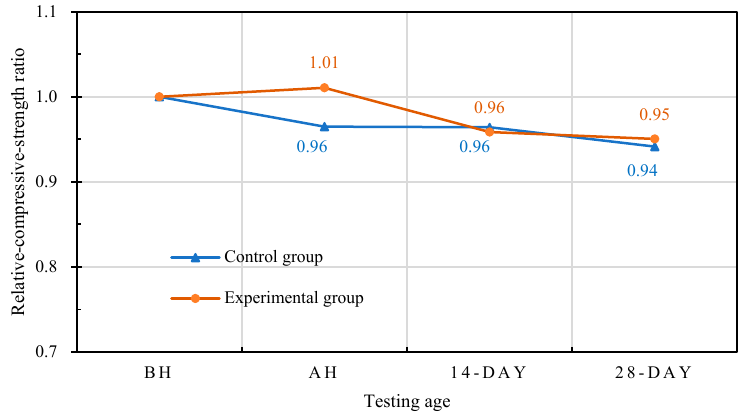
Figure 20. Effects of different self-healing ages on the relative-compressive-strength ratios of con- crete.